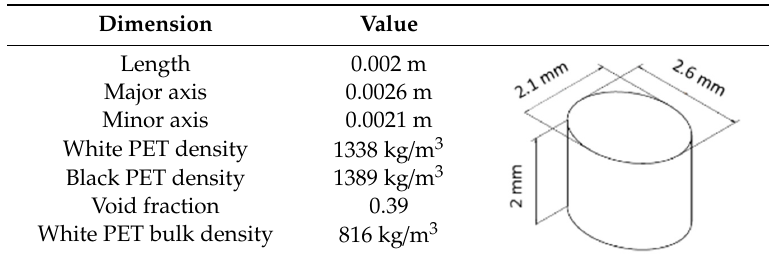
Table 2. Properties of the PET particles.